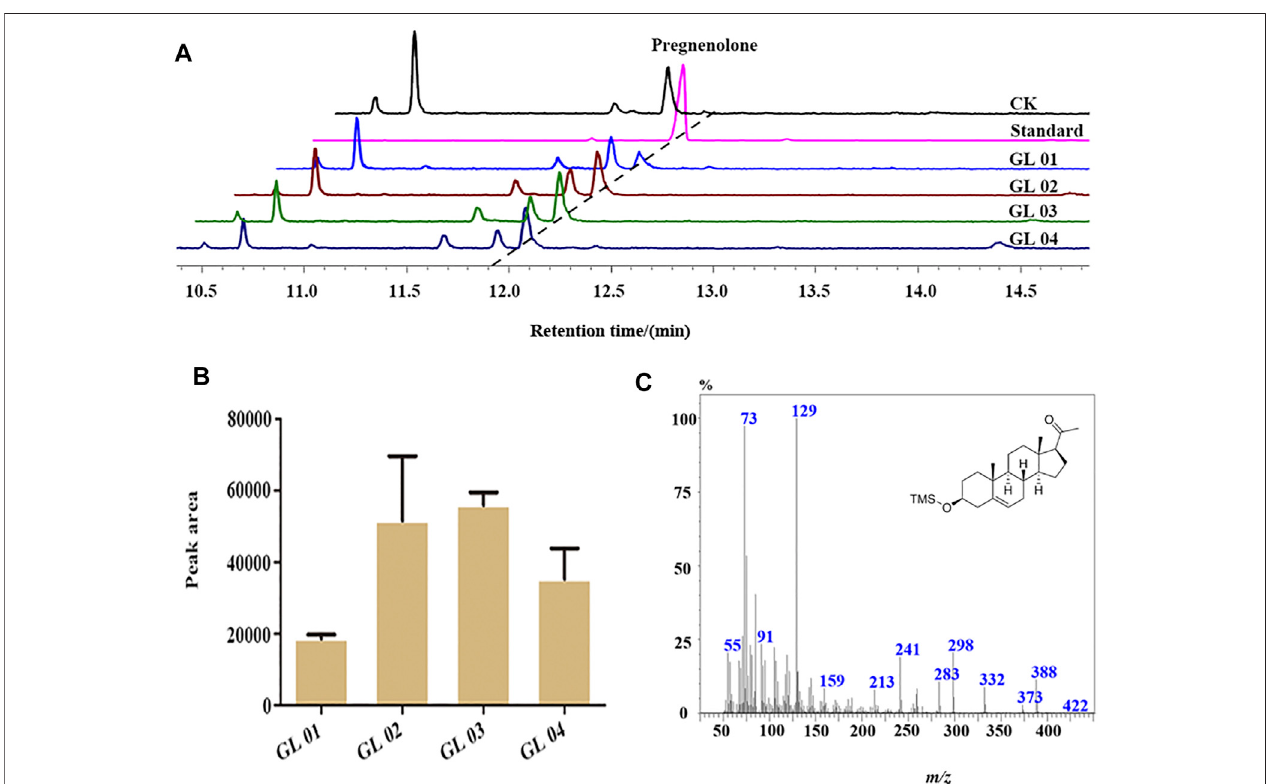
FIGURE 8 | GC-MS analysis of the products in the cultures of BbgCYP11A1 transformed yeast. (A) GC-MS total ion chromatograms examination the products of BbgCYP11A1 with various redox partners in yeast. CK, blank plasmid in strain; Standard, the compound of pregnenolone; GL01, Plasmid pESC-Leu-BbgCYP11A1 in strain; GL02, Plasmid pESC-Leu-BbgCYP11A1-AaCPR in strain; GL03, Plasmid pESC-Leu-BbgCYP11A1-BbgAdx-2A-BbgAdR in strain; GL04, Plasmid pESC-Leu- BbgCYP11A1-MmAdx-2A-MmAdR in strain. (B) The peak area of BbgCYP11A1 for pregnenolone production with different redox partners. (C) The mass spectrum of the chemical in the samples of transforming yeast at 11.95 min of retention